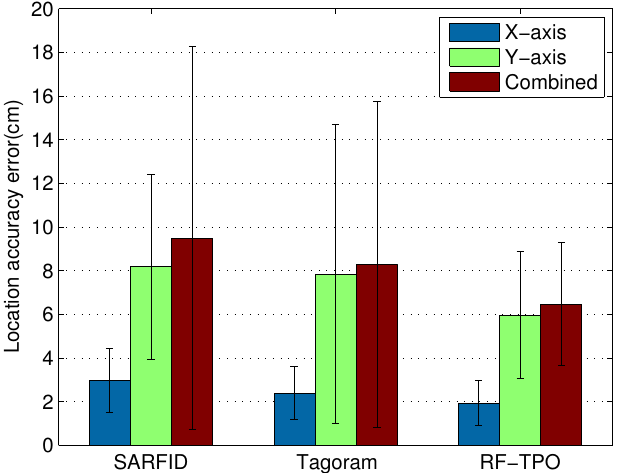
Figure 12. Cumulative distribution function (CDF) of RF-SML localization accuracy.